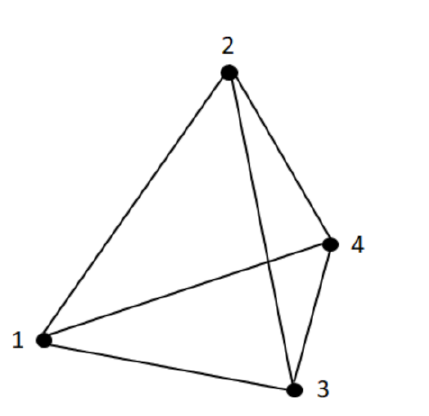
Figure 1. A simple grid